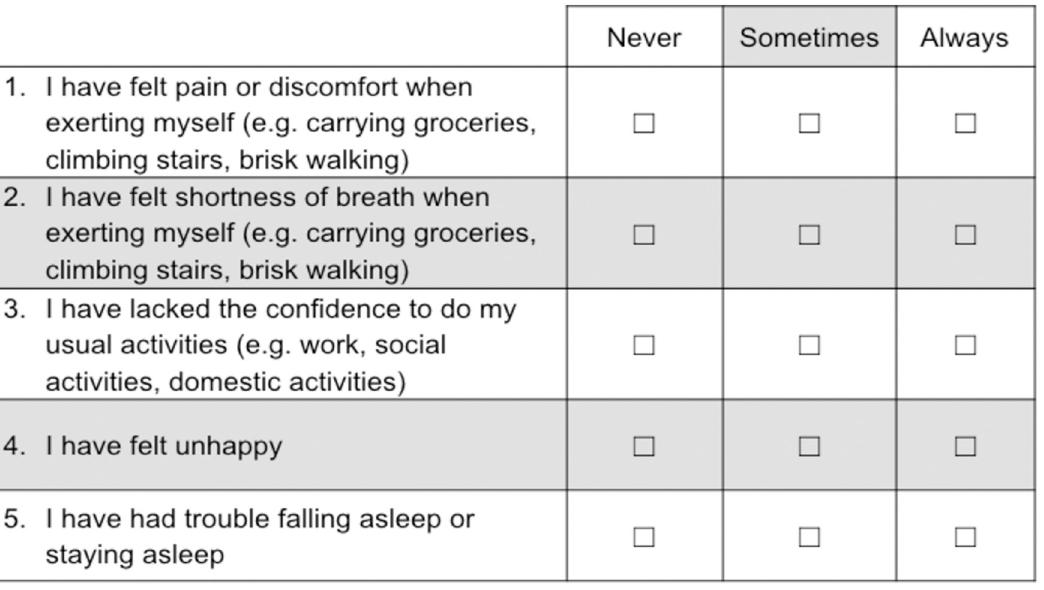
Fig 1. The final Monash University cardiac patient-reported outcome measure (MC-PROM) for patients following percutaneous coronary